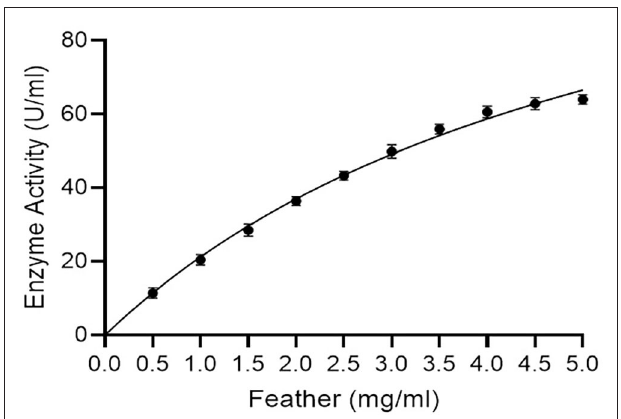
FIGURE 5 | Enzyme kinetics (Michaelis-Menton plot) for keratinase using a chicken feather as substrate ( R 2 = 0.9902).